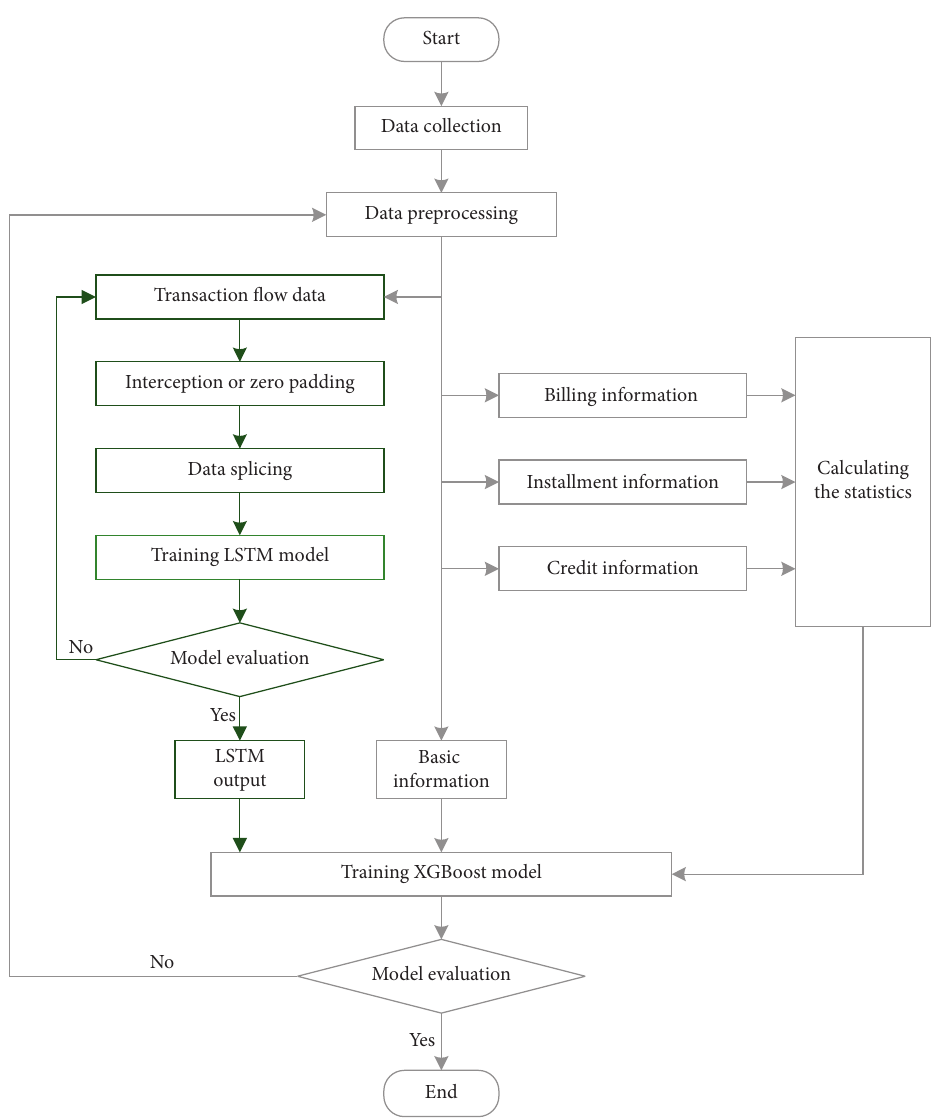
Figure 6: The flow chart of the XGBoost-LSTM model